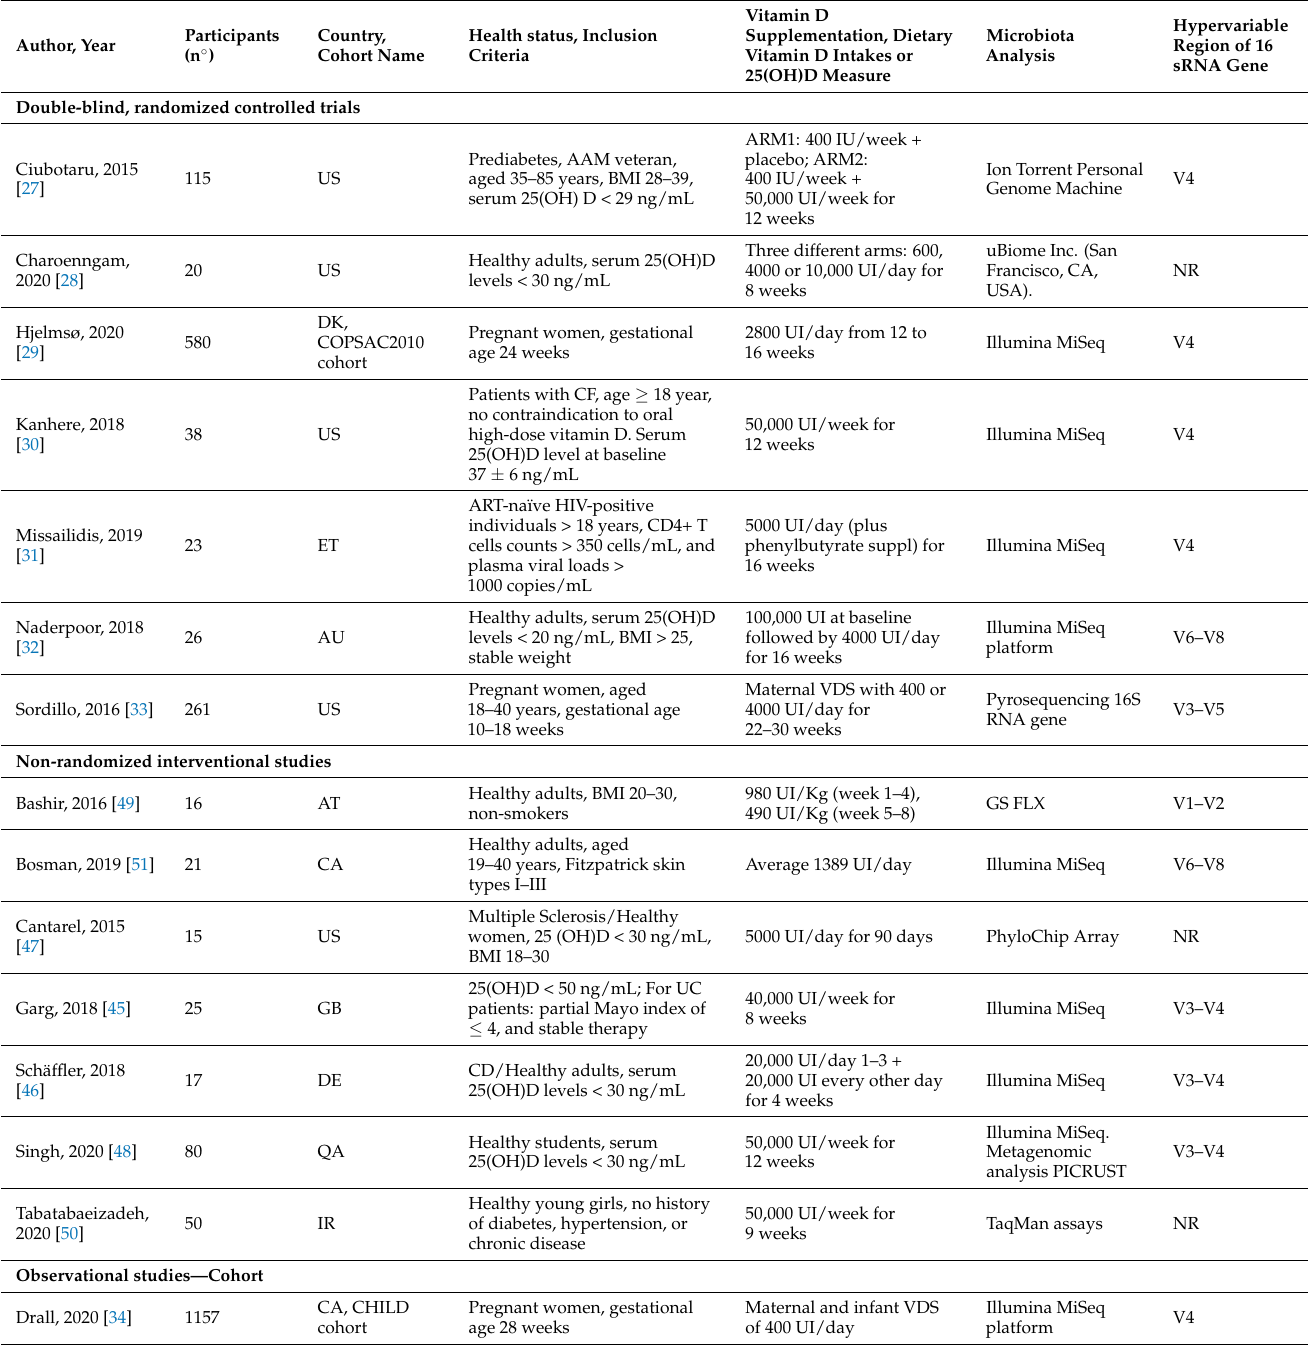
Table 1. Characteristics of selected